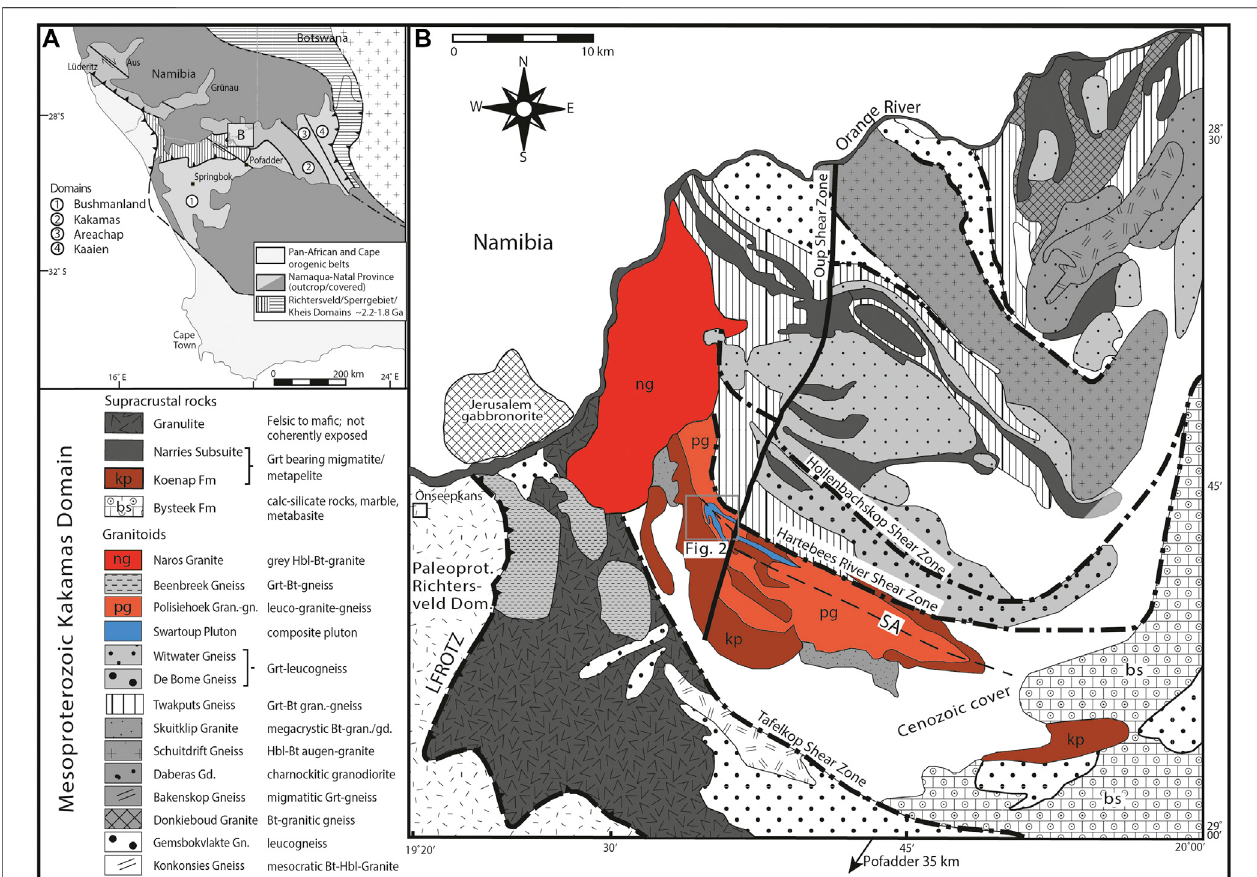
FIGURE 1 | Regional geology of the Namaqua Sector of the Namaqua-Natal Metamorphic Province. (A) . The four Mesoproterozoic domains of the Namaqua SectorandthePalaeoproterozoicbasementoftheRichtersveld,Sperrgebiet,andKheisDomainsinsouthwesternAfrica. (B) ThecentralNamaquaSectorinSouthAfrica withits maingranitic andsupracrustalentitiesand regionalshearzones. AlongtheLowerFishRiver-OnseepkansShearZone (LFROTZ;Maceyetal.,2015),therocksof the Kakamas Domain are thrusted over the Paleoproterozoic Richtersveld Domain. The position of the map in Figure 2 is highlighted. Maps A and B are modi fi ed after Bial et al. (2015b) and references therein. SA: Swartmodder antiform.